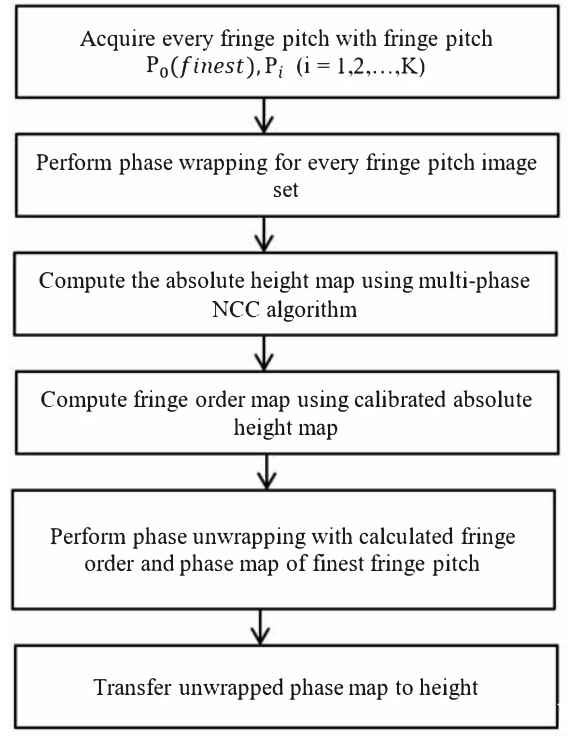
Figure 7. Flowchart of precise absolute depth measurement using the multiphase normalized cross-correlation (NCC)